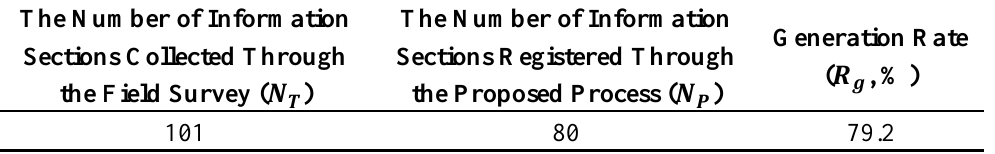
Table 8. Results of the performance assessment of the proposed methodology.